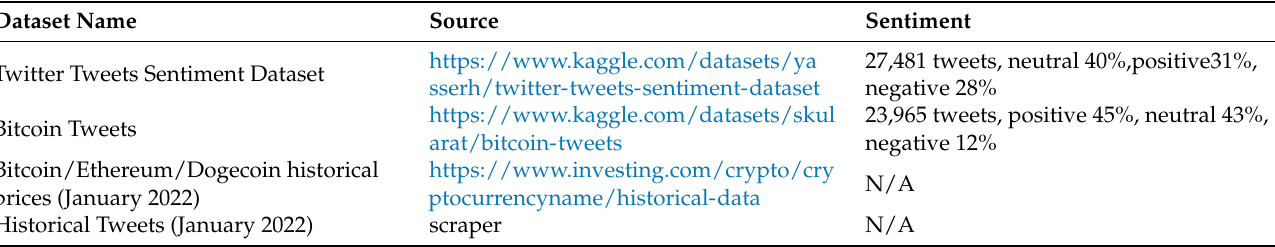
Table 2. Dataset